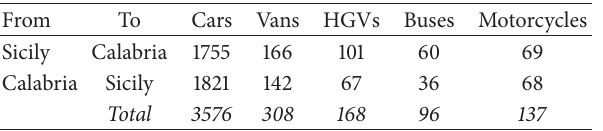
Table 1: Wheeled vehicles crossing the Strait of Messina from 6a.m. to 10p.m.